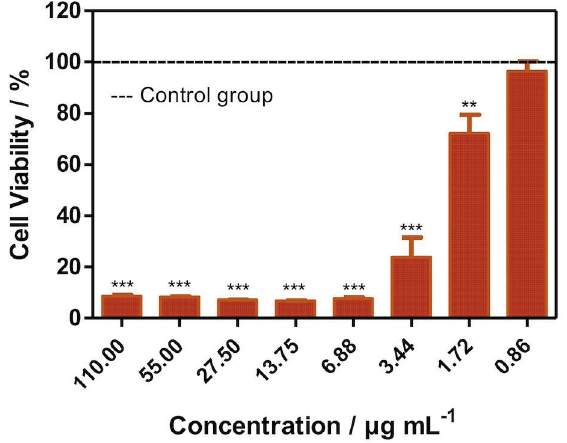
Table I) and AgNPs-Cit (CC